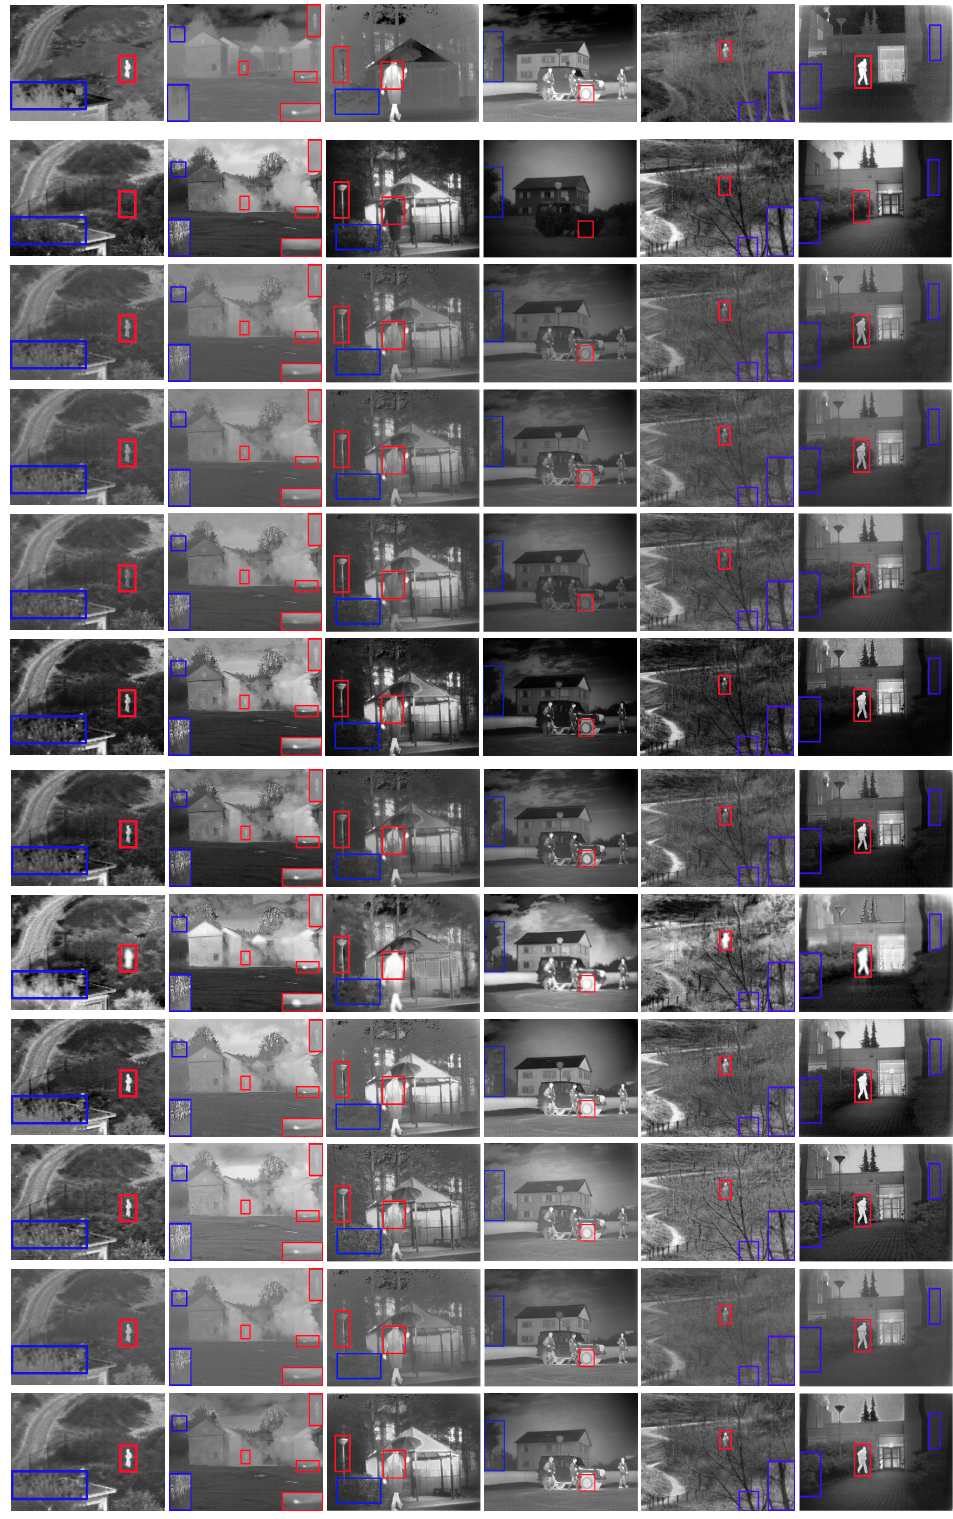
Figure 3. Subjective result images of the ten fusion methods. From top to bottom in order: infrared images (IR), visible images (VIS), VggML, Resnet50, BayF, AUIF, CSF, DDcGAN, SeAFusion, VEHMD, YDTR, and our method (Ours). From left to right in order: “Camp,” “Octec,” “Kaptein 1654,” “Jeep,” “Sand-path,” and “Kaptein 1123”. The red and blue boxes show the enlarged local regions.